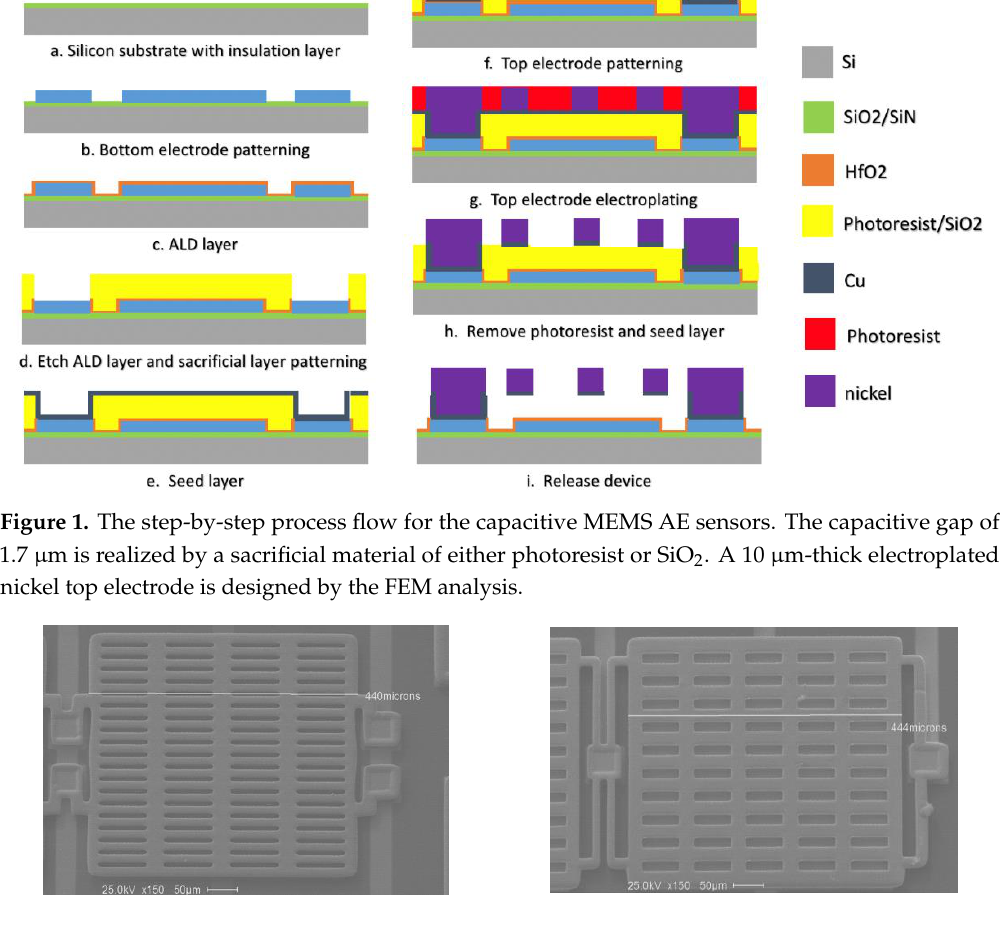
Figure 2. The sensor SEM images, including ( a ) the HF design; ( b ) the LF design.